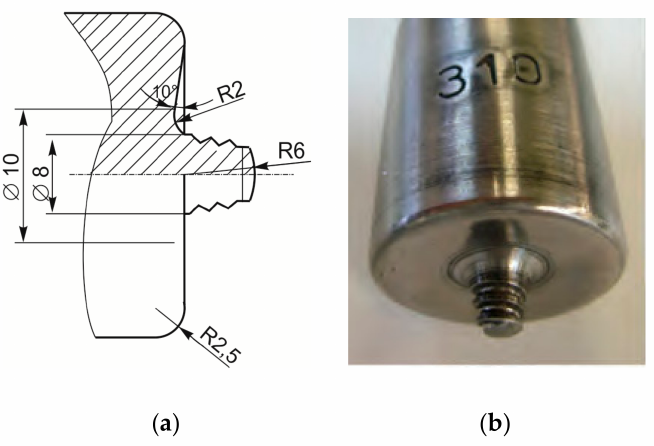
Figure 2. FSW tool geometry ( a ); FSW tool ( b ).